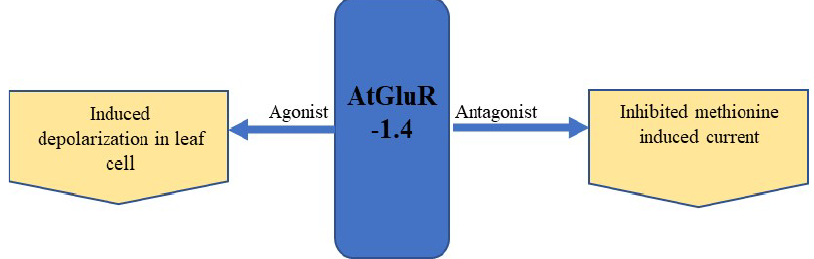
Figure 7. Expression and effect of the agonist and antagonist on AtGluR-1.4.